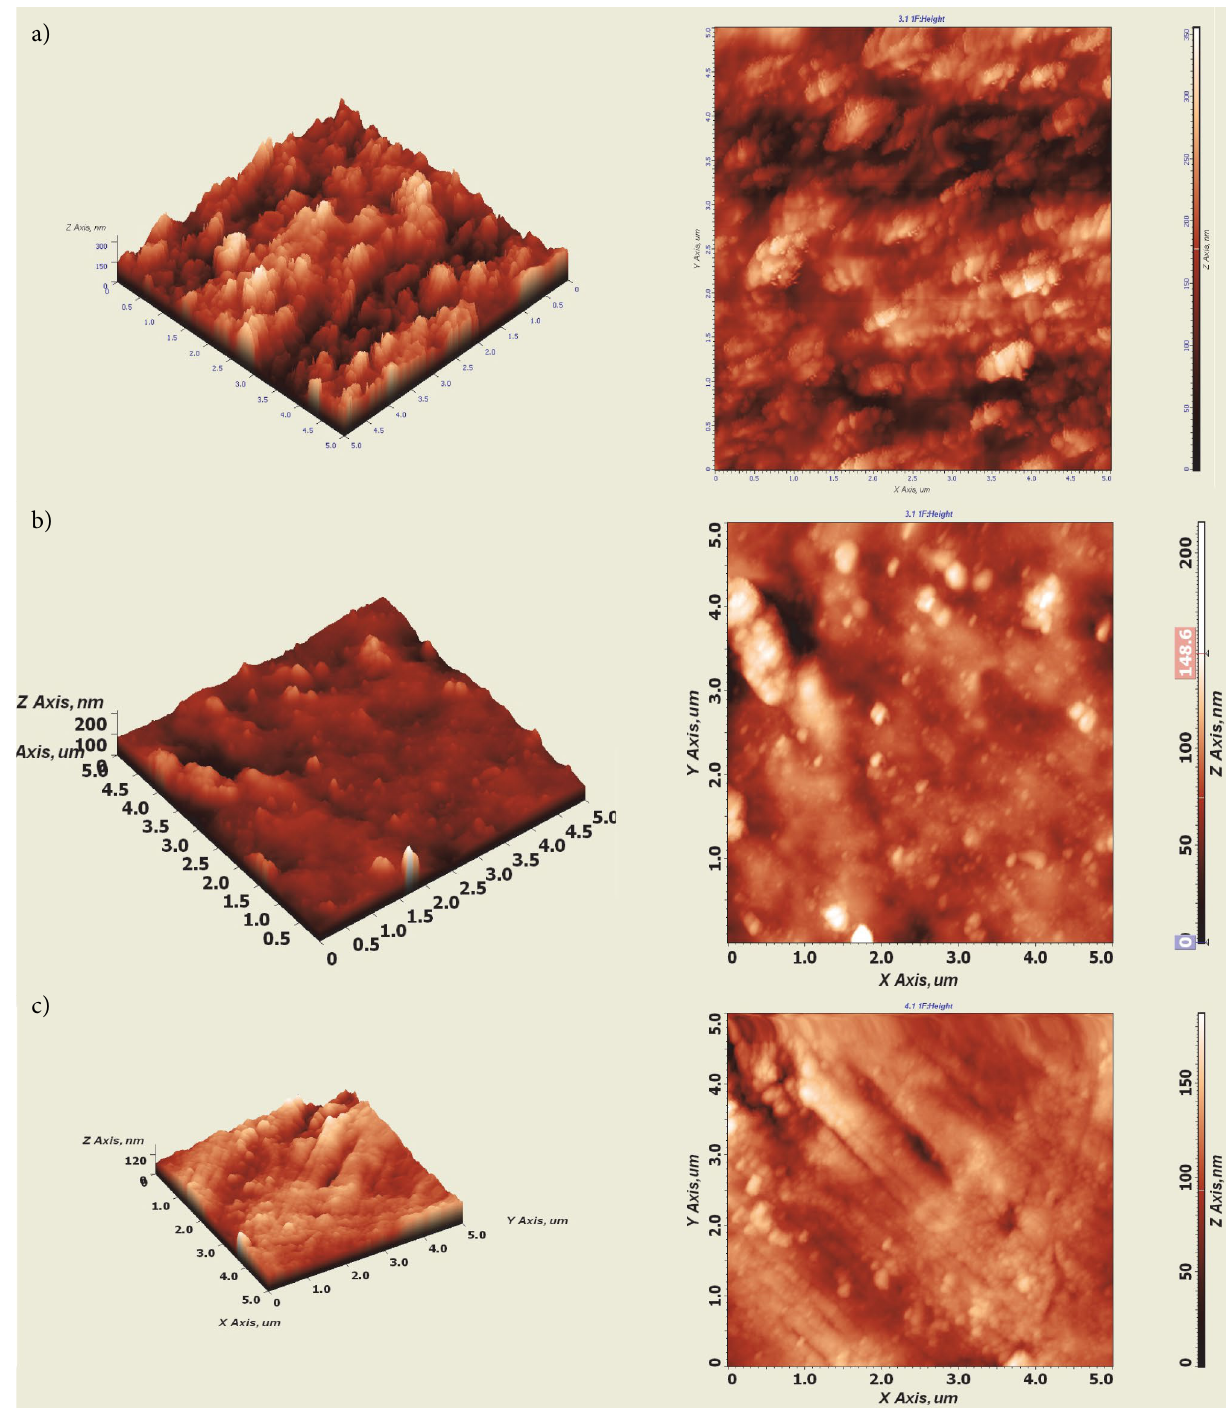
Fig. 7. AFM images of the uncrosslinked and cross linked PVA-PES membranes used in the present study (a: PVA-PES uncrosslinked; b: PVA- PES-0.2% borax; c: PVA-PES-0.5%